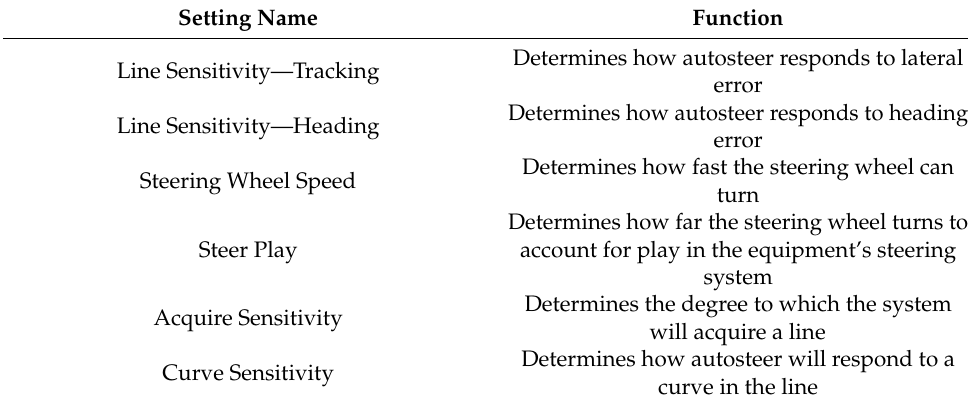
Table 3. List of available settings and their function within Auto-Trac 300.